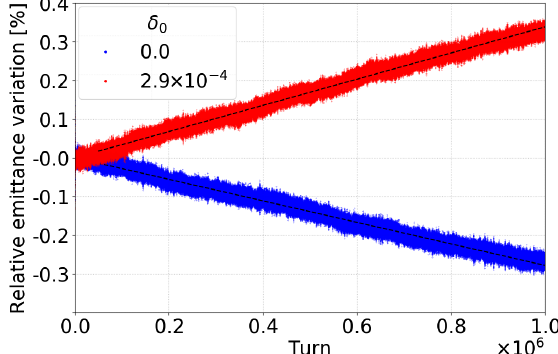
FIG. 1. Example of the relative variation of the transverse emittance in COMBI in a configuration with the numerical parameters listed in Tab. I, a chromaticity equal to 0, a feedback gain equal to 0.02 and a single IP. The configuration without additional noise is dominated by numerical stochastic cooling (blue curve). The emittance growth rate caused by the presence of noise with a r.m.s. amplitude of δ 0 ¼ 2 . 9 × 10 − 4 is given by the difference of the slope obtained with linear fits shown with black dashed lines.